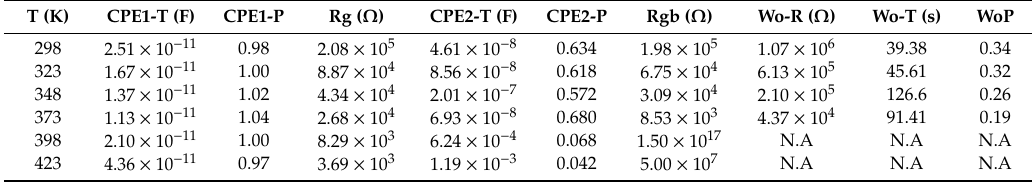
Table A3. Circuital element values from equivalent circuit fitting of the experimental results for Mn8. T